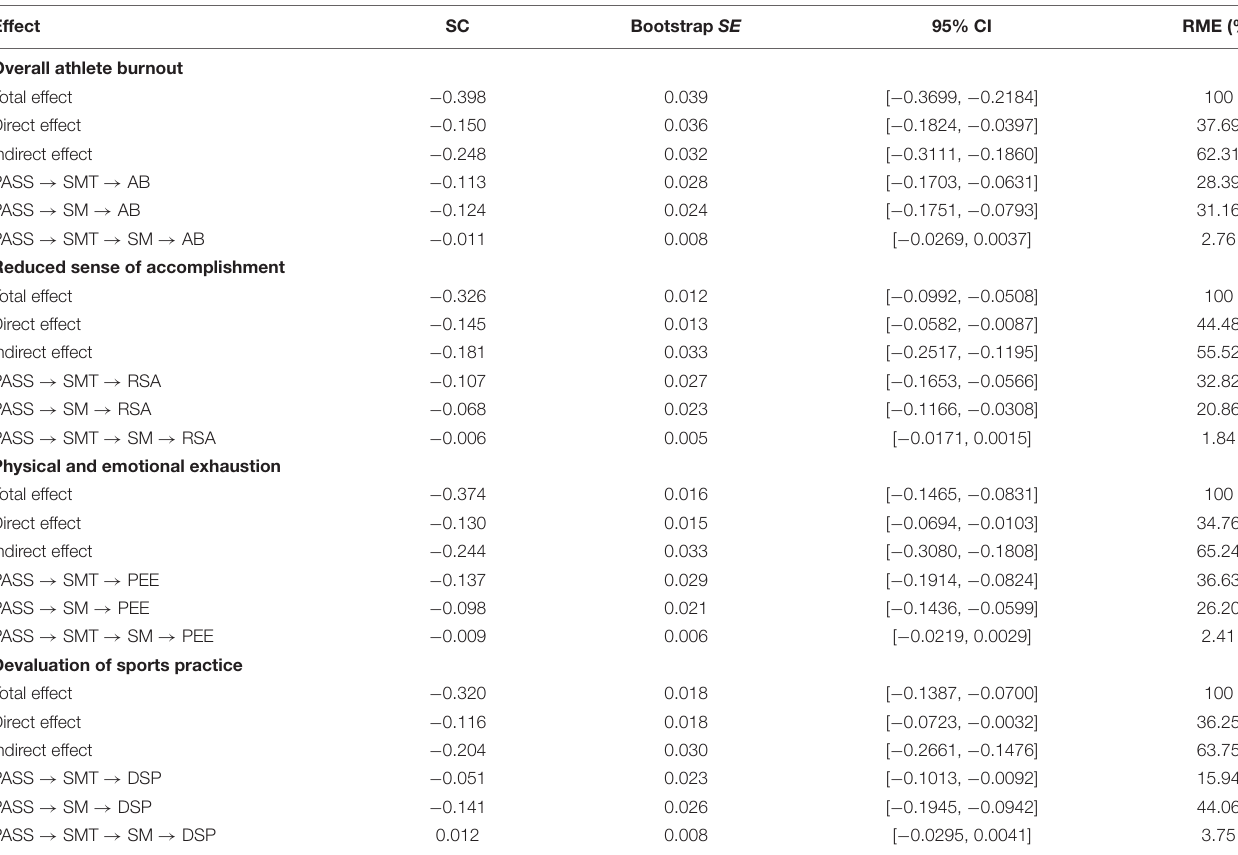
TABLE 5 | Summary of the mediating effect of mental toughness and sports motivation between social support and athlete